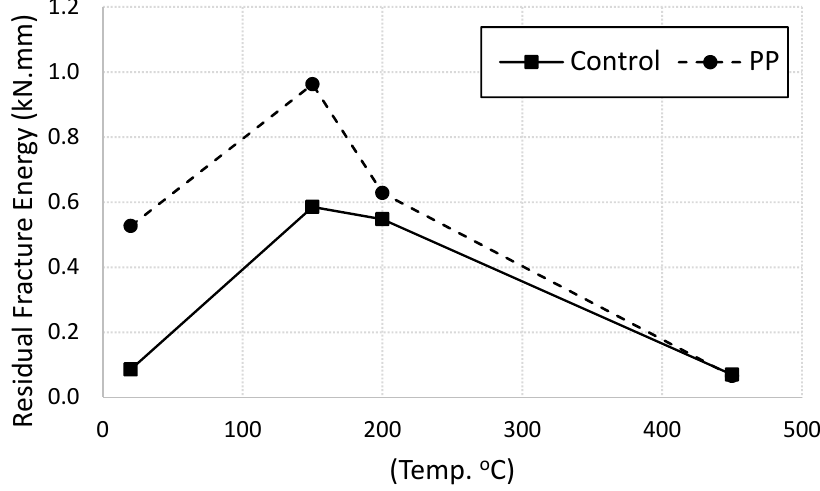
Figure 6. Residual fracture energy for control and fiber-reinforced specimens.